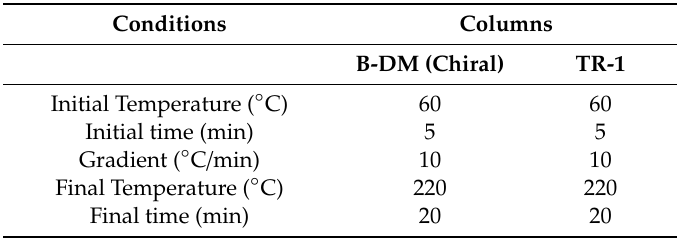
Table 6. The microwaves oven is a monomode CEM